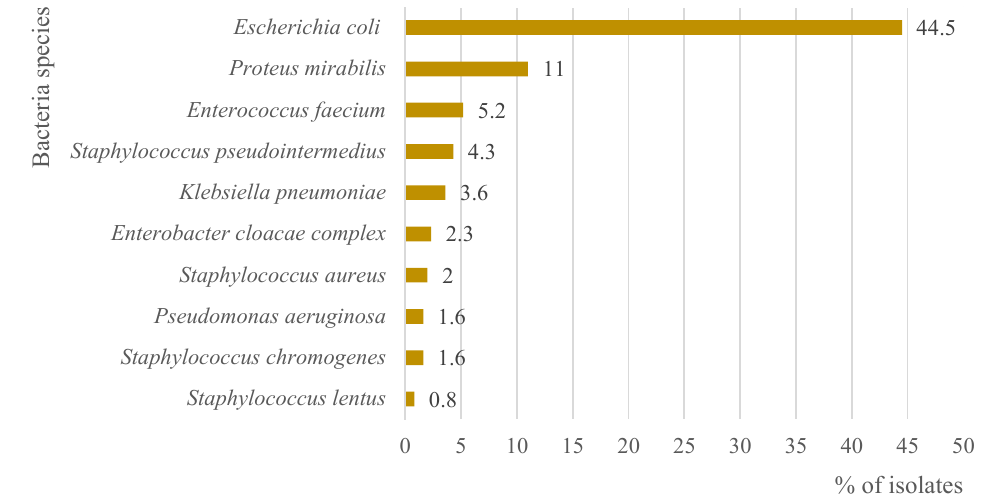
Figure 1. Negative and positive cultures grown from the 17472 urine samples from dogs and cats submitted to the INNO veterinary laboratory between 2017 and 2021.